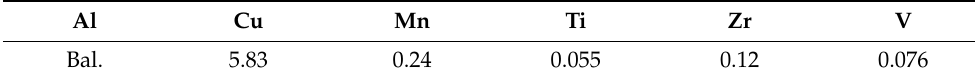
Table 1. Chemical composition of 2219 aluminum alloy (wt,